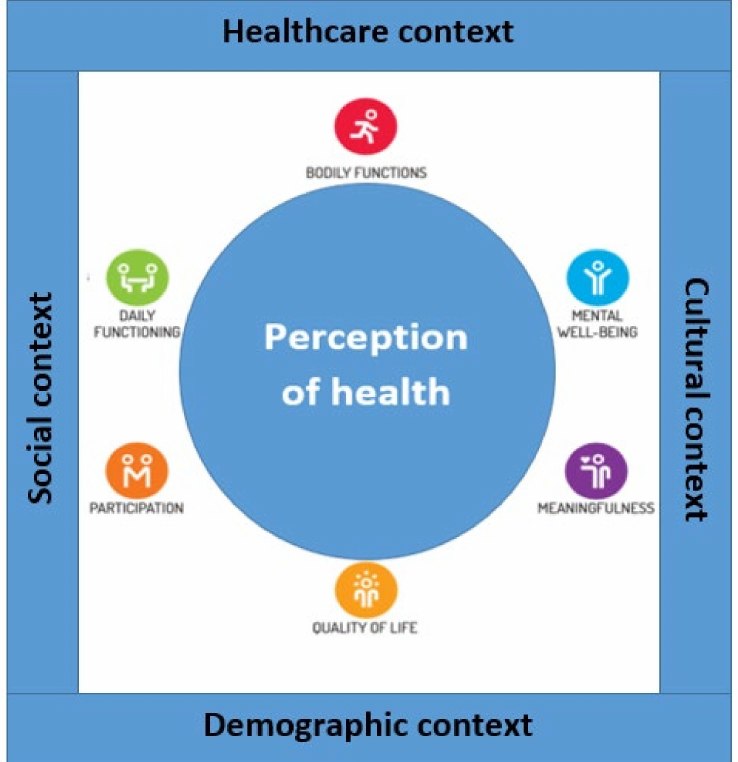
Figure 1. Conceptual framework: the six dimensions of health perception and its determining contexts. Based on Huber’s ‘Concept of Positive Health’